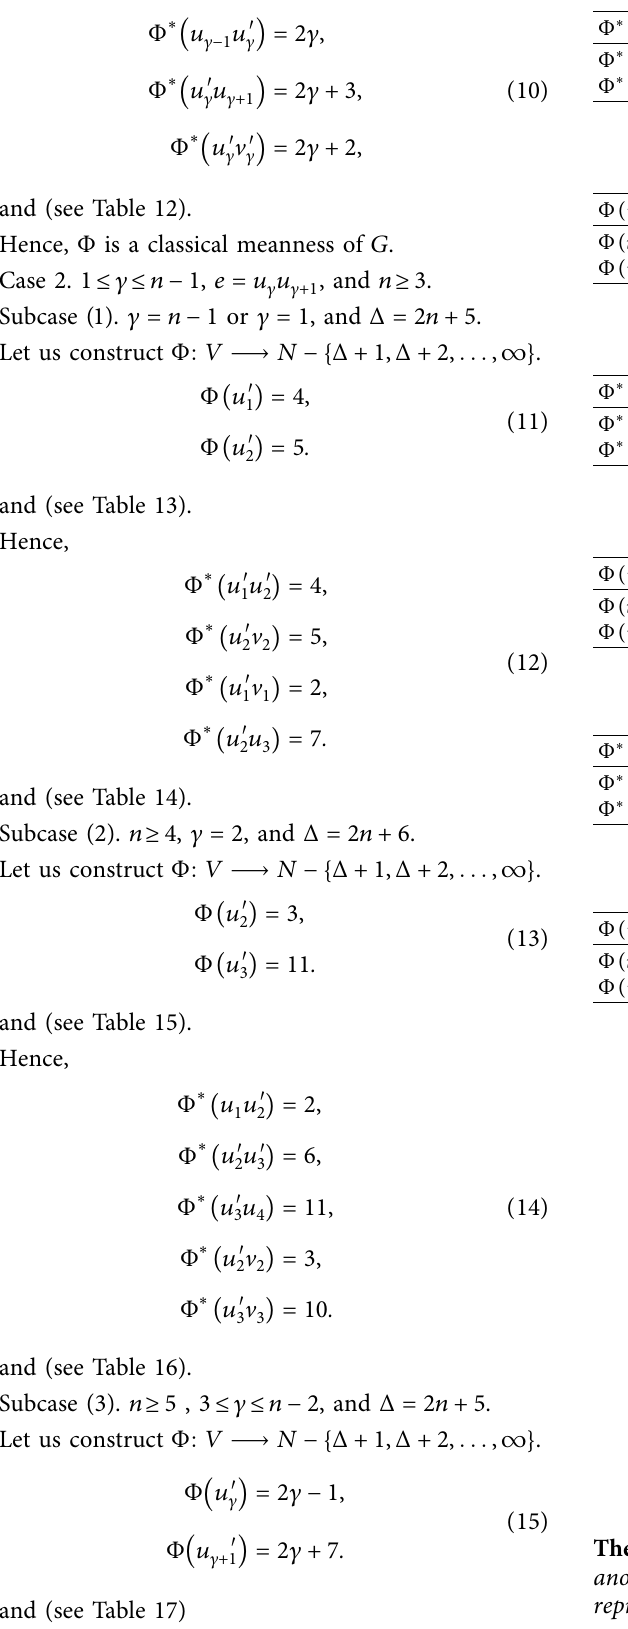
Table 12: Edge labeling of Φ ∗ ( e ) .